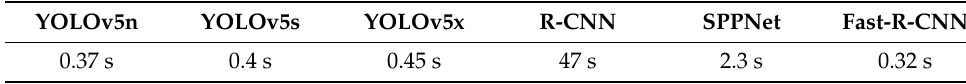
Figure 17. Loss curves with mAP.